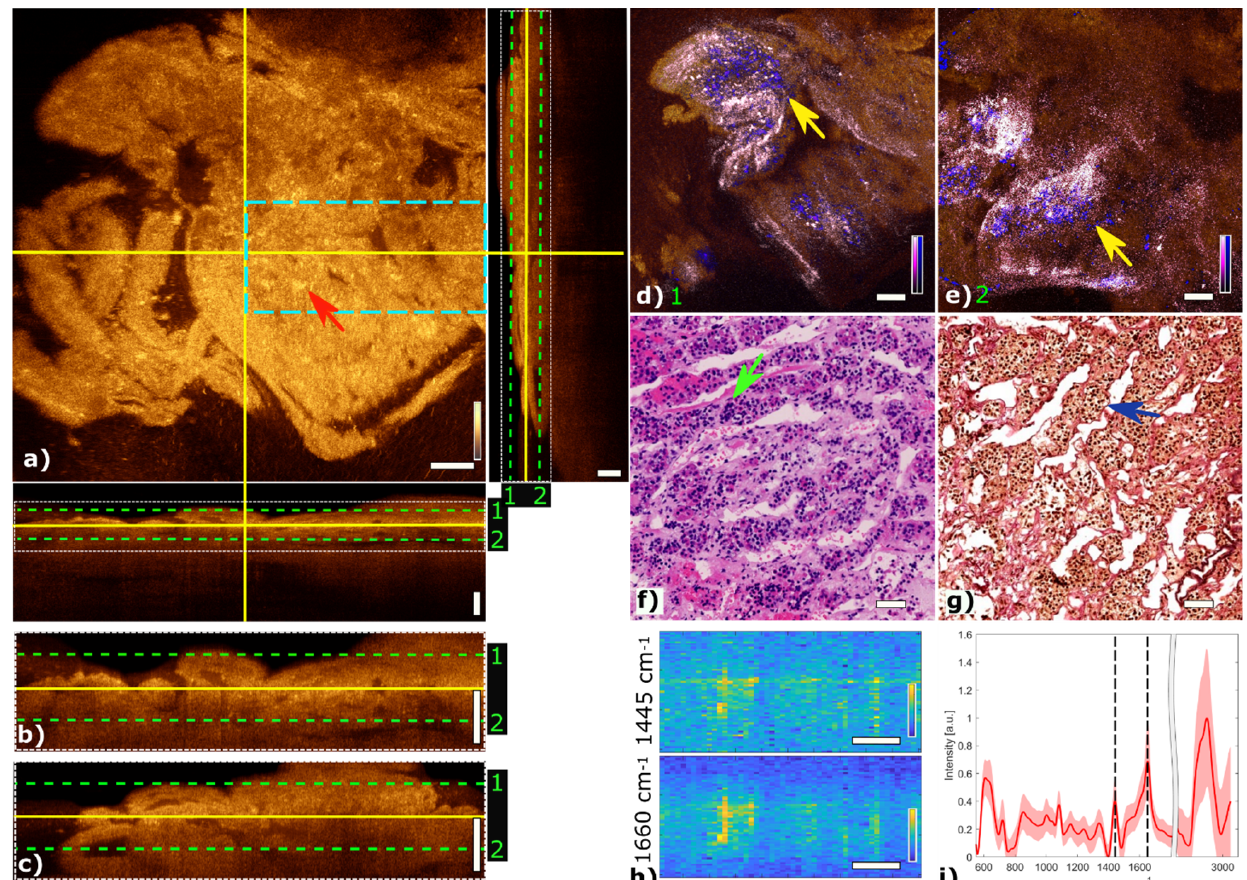
Figure 3. Multimodal investigation of pituitary gland. ( a ) OCT orthogonal view: en face image shows plane at the depth indicated in B-scans (depth profiles) with yellow lines. OCT en face and B-scans were averaged 5 times. Red arrow indicates a cell nest. The green dashed lines (1 and 2) in the OCT B-scans indicate the position of the overlaid OCT-MPM images. The blue dashed rectangle points out the region where the LSRM scan was performed. White dotted rectangles in OCT B-scans indicate positions of magnified regions of interest. ( b , c ) Magnified horizontal and vertical OCT B-scans. ( d , e ) MPM combining SHG and TPEF signals overlaid with OCT at different depths. NADH and FAD information (TPEF) reveals contrast corresponding to pituitary cells in blue, and collagen (SHG) shows the scaffold structure surrounding the cells in bright pink, respectively. Yellow arrows indicate cell nest with surrounding connective tissue. ( f ) Corresponding H&E-stained image of pituitary gland biopsy. Green arrow marks a cell nest. ( g ) Corresponding EVG-stained image giving contrast from connective tissue in pink. Blue arrow marks surrounding connective tissue. ( h ) LSRM images at 1445 cm − 1 and 1660 cm − 1 provide molecular contrast assigned to collagen, proteins and lipids, respectively. The corresponding Raman bands are shown and marked with black dashed lines on the mean Raman spectrum ( i ). All scale bars indicate 50 µ